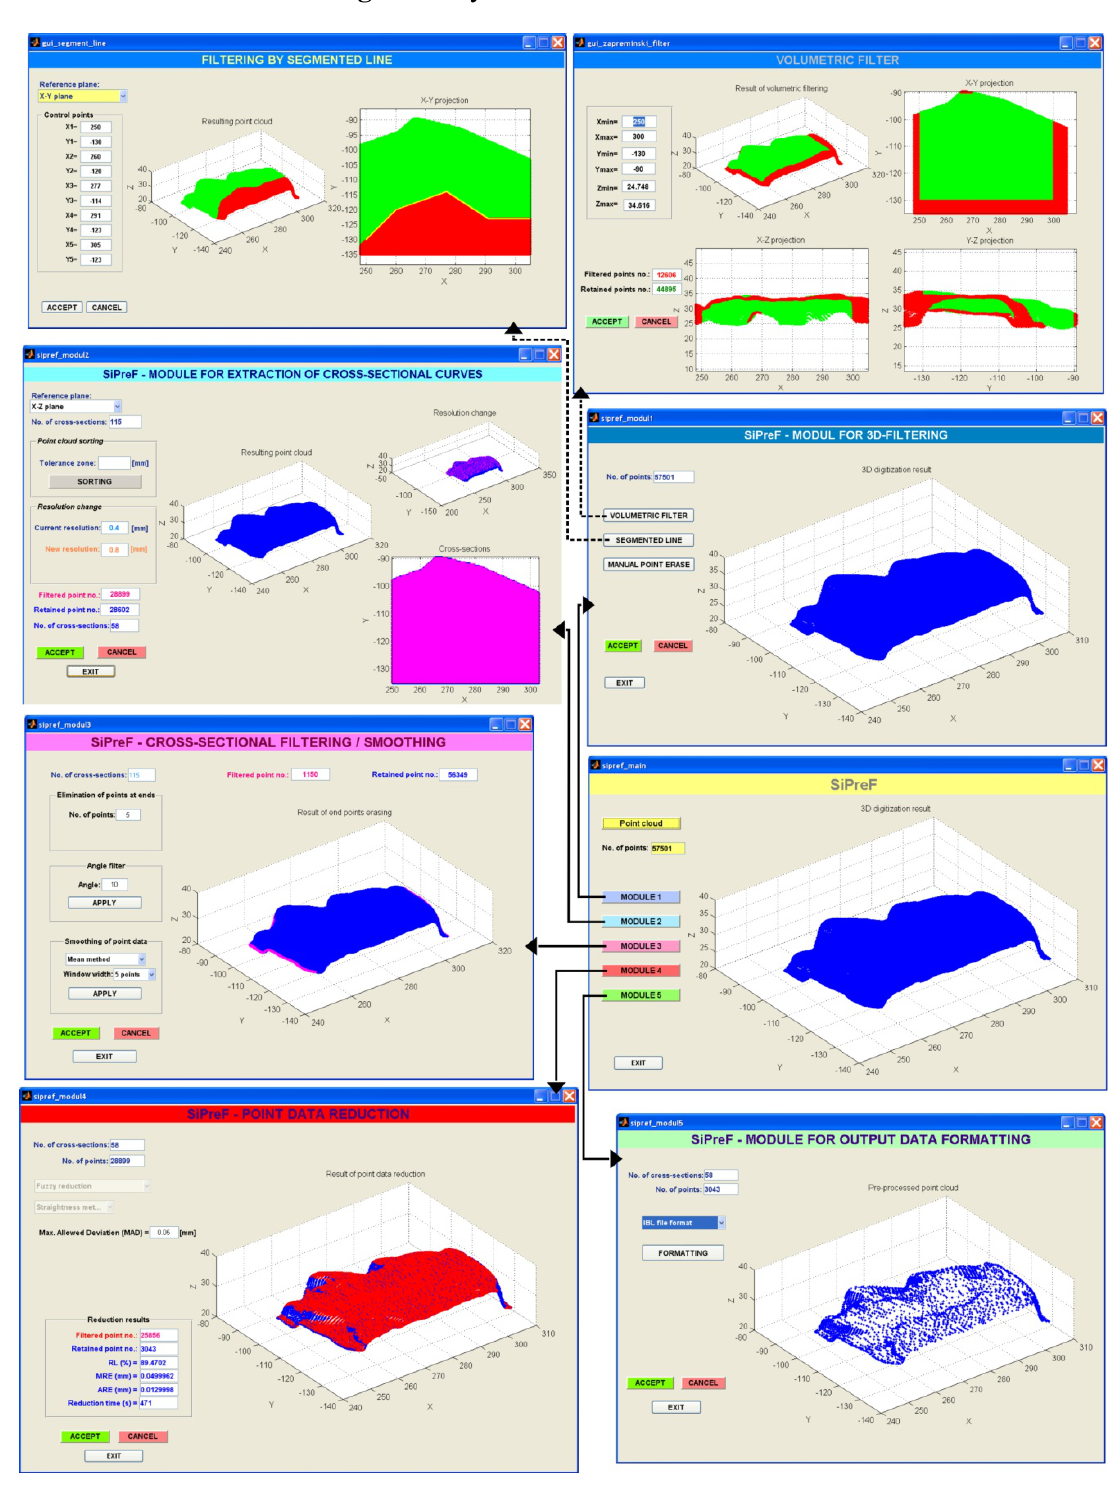
Figure 9. SyPreF module’s